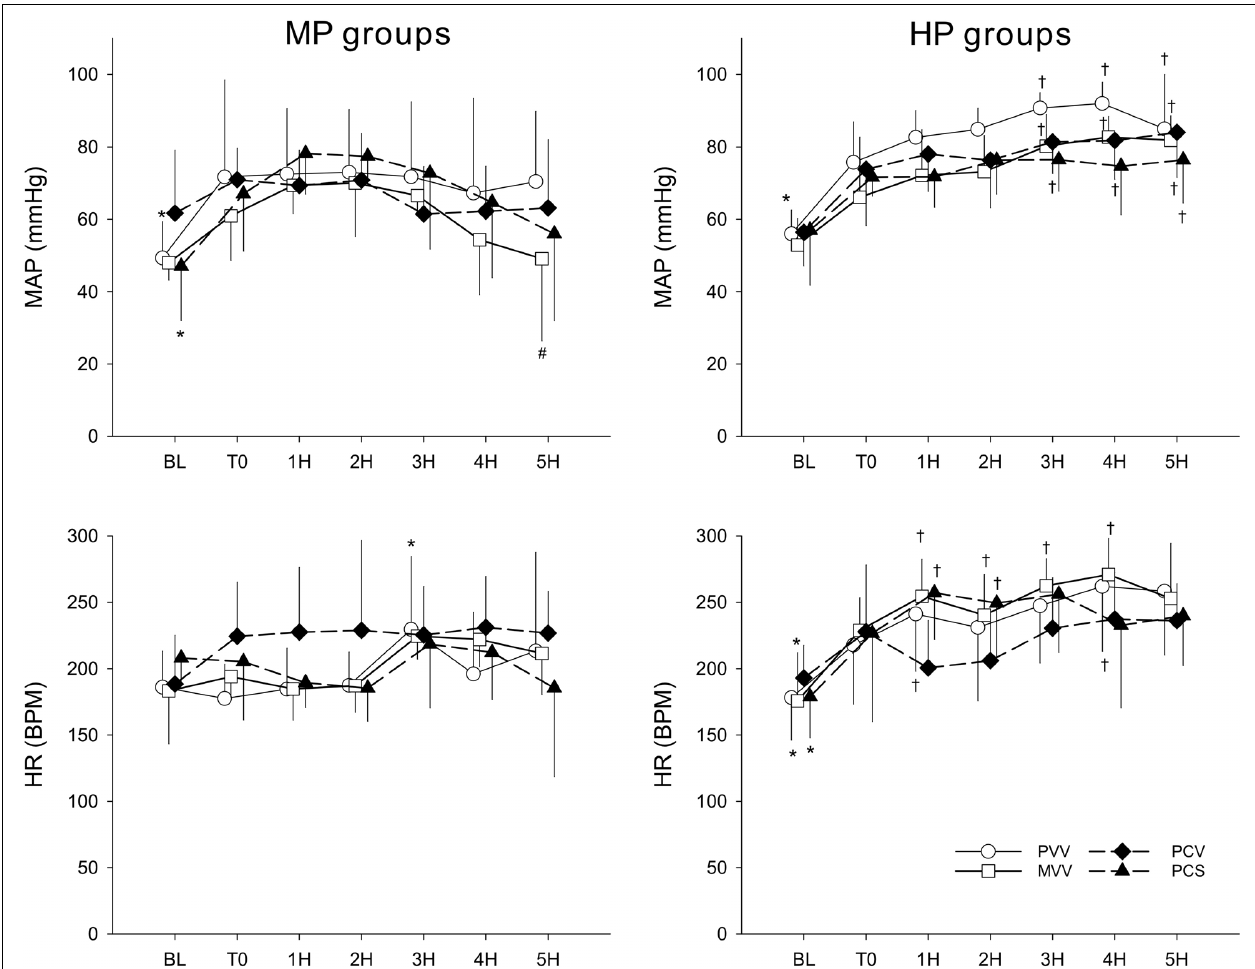
FIGURE 4 | Changes in haemodynamic parameters before (BL), after the induction of lung injury (T0), and during the application of various ventilation modes. Left panels display changes in groups ventilated with a PEEP of 6 cmH 2 O, whereas groups depicted in the right panels were ventilated with a PEEP of 9 cmH 2 O. Data are presented as group means ± half-width of 95% confidence interval. MP, moderate PEEP. HP, high PEEP. MAP, mean arterial pressure. HR, heart rate. BPM, beats per minute. 1H–5H, averages of measured parameters during the corresponding 1 h period of ventilation with an experimental pattern. PVV, physiological variable ventilation. MVV, mathematical variable ventilation. PCV, pressure-controlled ventilation. PCS, pressure-controlled ventilation with regular sighs. Results of the ANOVA analyses ( p -values) for factor “ventilation mode.” p < 0.01 for MAP and p = 0.79 for HR; for factor “PEEP”: p < 0.01 for all variables; for the interaction of “ventilation mode ∗ PEEP”: p = 0.24 for MAP, p < 0.01 for HR; for interaction of “ventilation mode ∗ PEEP ∗ time”: p < 0.01 for all variables. ∗ p < 0.05 vs. T0. # p < 0.05 vs. PVV. † p < 0.05 vs.